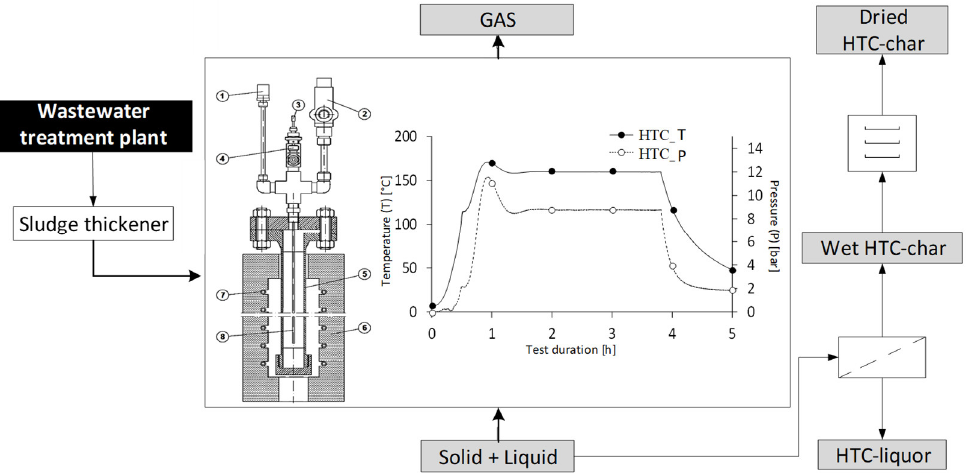
Figure 1. HTC experimental unit and pressure and temperature variation at 160 °C, 3 h HTC test. Modified from [24]. 1 – pressure sensor; 2 – safety valve; 3 – thermocouples; 4 – sampling valve; 5 – reactor tube; 6 – insulation; 7 – heater; 8 – thermocouple.